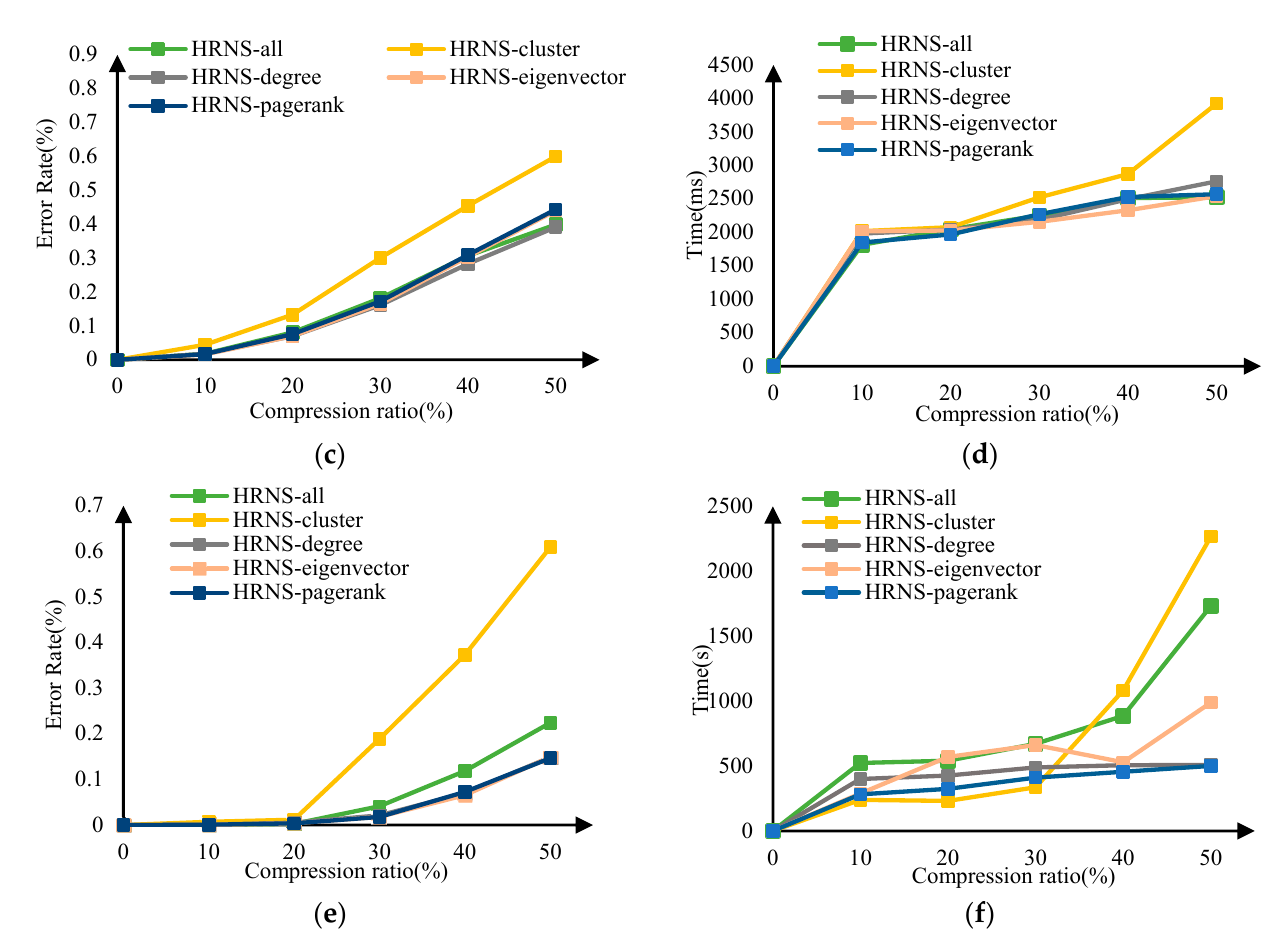
Figure 9. Graph summary error of different ranking strategies. ( a ) Summary error rate (2000-2 dataset). ( b ) Running time (2002-2 dataset). ( c ) Summary error rate (UCforum dataset). ( d ) Running time (UCforum dataset). ( e ) Summary error rate (Wikipedia elections dataset). ( f ) Running time (Wikipedia elections dataset).